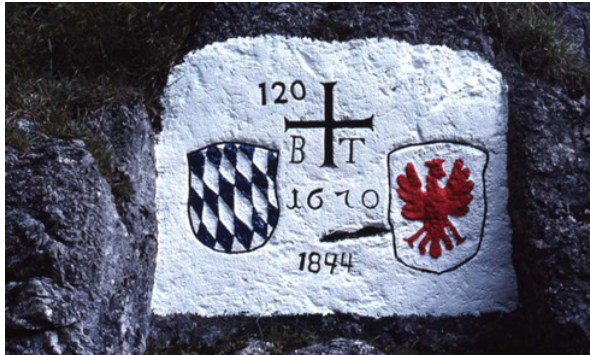
Figure 6. State border mark between Tyrol (Austria) and Bavaria (Germany) from 1670. (Photo H.